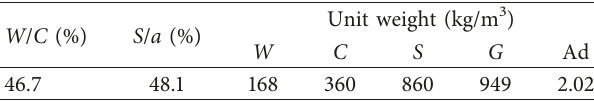
Figure 1: Details of test specimens. (a) R41. (b) R55. (c) R87. Table 1: Mixture properties of